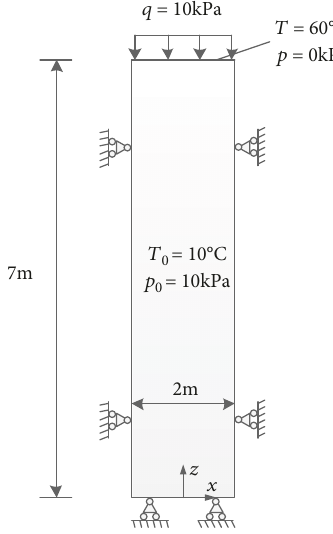
Figure 4: Illustration of the 1D thermal consolidation